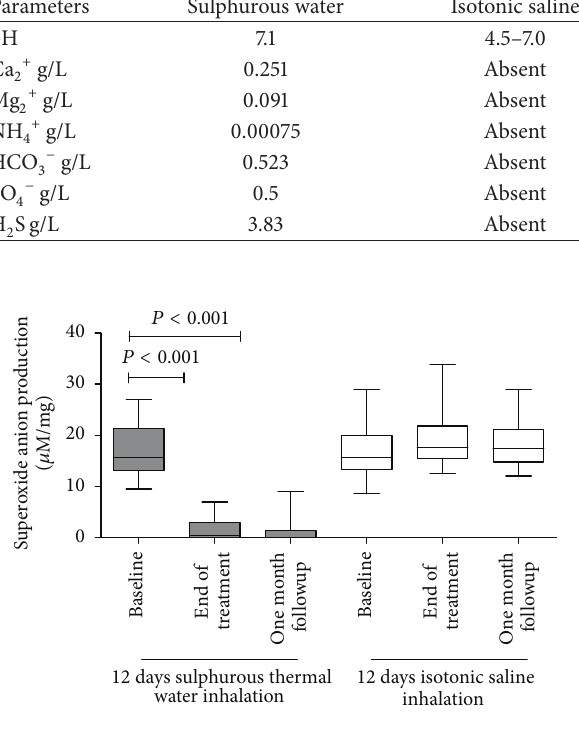
Figure 1: Superoxide anion production in COPD patients at the baseline, at the end of the inhalation treatment, and one month after the end of the treatment.